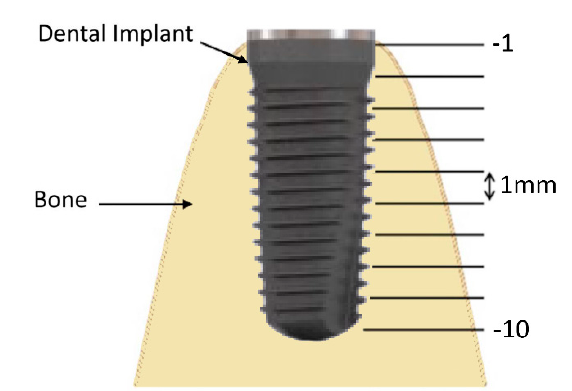
Figure 6. Points of measurement distributed along the bucco-lingual center of implant with a distance of 1 mm between two points.